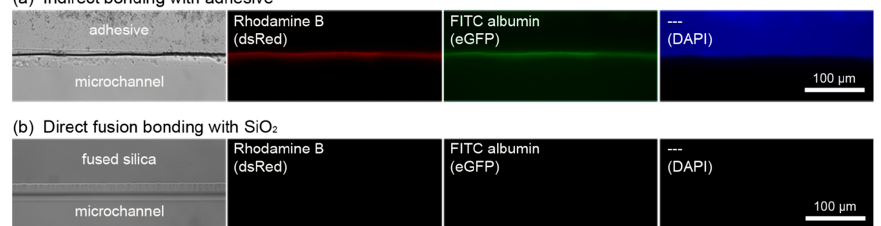
955 PY. ( b ) Microfluidic channel manufactured with a direct fusion bonding method; from left to right: microscopic bright field image; microscopic fluorescence image, taken with DsRed filter, channels were flushed with 40 μ M Rhodamine B and subsequently rinsed with water; microscopic fluorescence image, taken with eGFP filter, channels were flushed with 1 g·L − 1 FITC-albumin and subsequently rinsed with water; microscopic fluorescence image, taken with DAPI filter, channels were flushed with water.